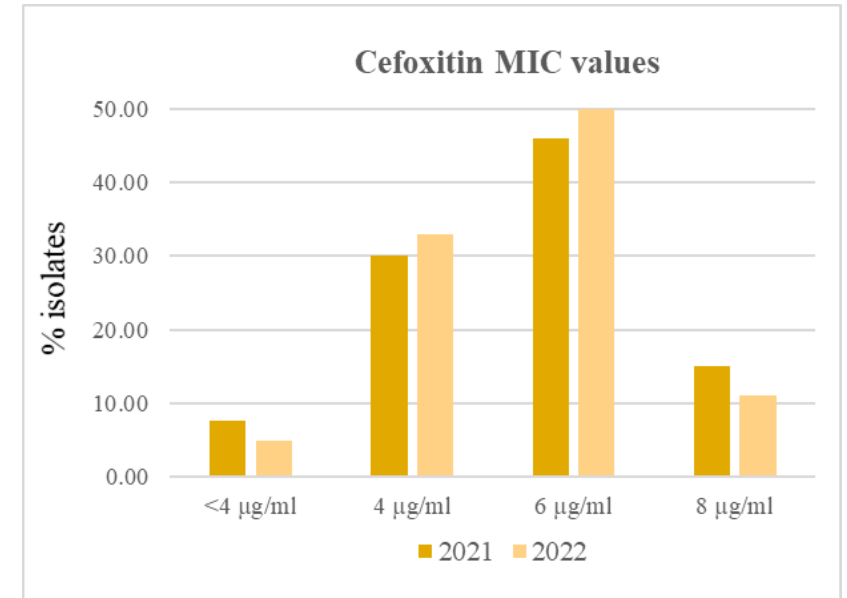
Figure 1. Percentages of isolates with different MIC values for cefoxitin in the years 2021 and 2022.